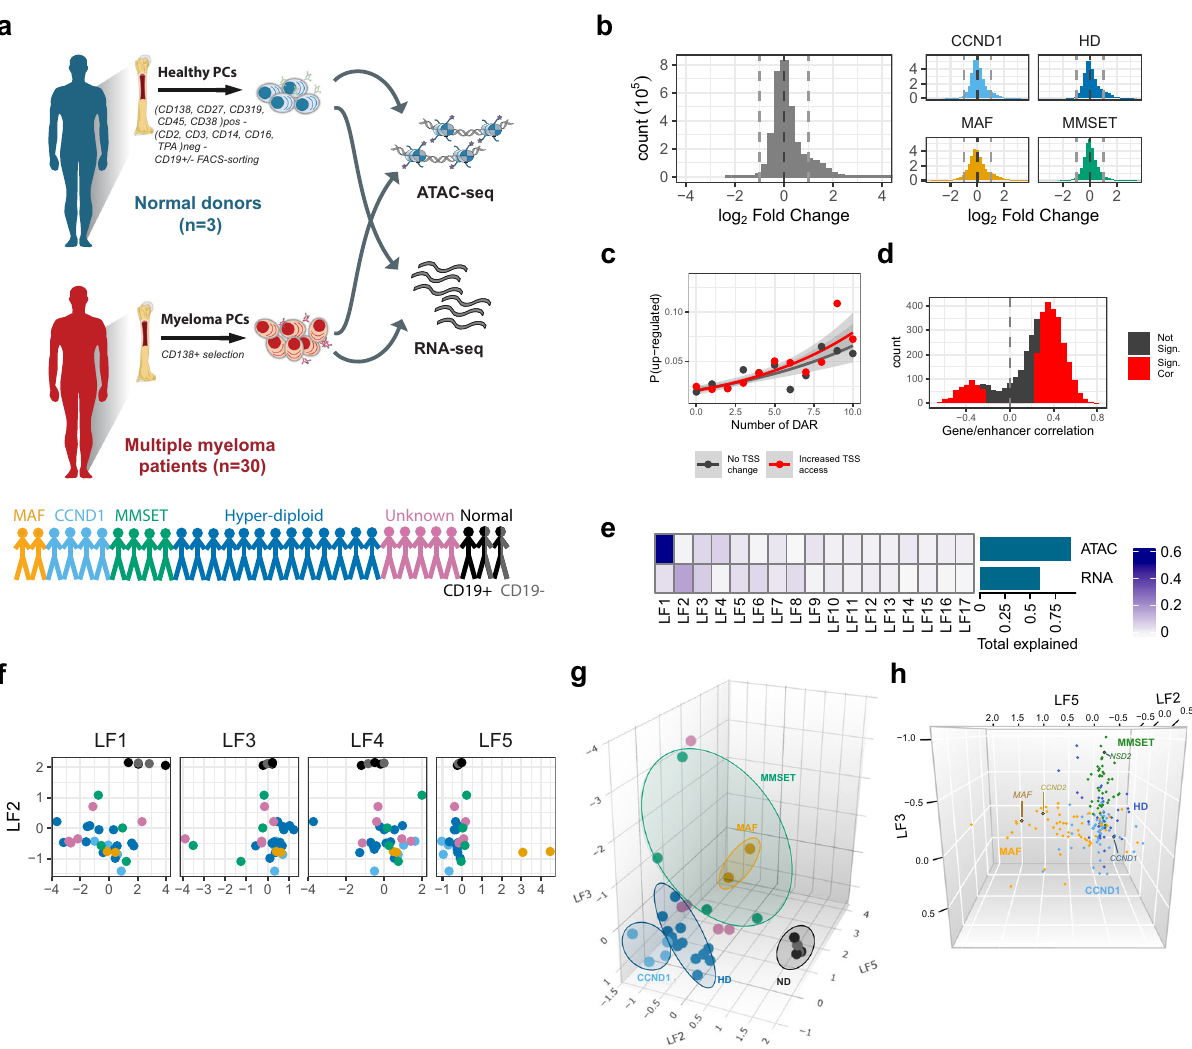
Fig. 1 Over-accessible distal chromatin classi fi es myeloma genetic subgroups. a Study patient population and design. Transcriptome and chromatin accessibility were assessed by RNA-seq and ATAC-seq respectively in myeloma PC from 30 MM patients and PC from three healthy donors. For two of the controls we obtained samples of both CD19 + and CD19 − PC. b Changes in average ATAC-seq signal over pan-myeloma (left) and subgroup (right) peaks expressed as normalized log 2 myeloma/normal PC read count. Signi fi cant changes in the pan-myleoma plot (left) are shown in a darker colour. c Logistic regression of number of differentially accessible regions (DAR) within 500 kb of a gene ( x -axis), whether a gene has a signi fi cantly more open promoter in myeloma (red – yes, black – no) on the probability of the gene being differentially upregulated in myeloma. Points represent fraction of genes upregulated with a given number of DAR within 500 kb and TSS status, and lines represent model fi t, grey ribbon 95% con fi dence interval. Genes with 10 or more DAR were pooled together. d Correlation of signal for differentially accessible ATAC-seq regions and differentially expressed genes within the same topology associating domain (TAD). e Variance explained by the fi rst 17 latent factors (LF) for each of RNA-seq and ATAC-seq signals as calculated by multi-omics factor analysis (MOFA). f , g LF scores for each sample for the fi rst fi ve latent factors in the MOFA model. Subtype for each sample is denoted by colour, as per ( a ). LF1 and LF2 distinguish normal from MM samples, LF5 distinguishes MAF and CCND1 samples from the rest. h LF scores for a subset of regions and genes used as predictors by MOFA analysis and previously identi fi ed as MM-subgroup classi fi ers 12 . The main driving oncogenes MAF, CCND1, CCND2 and NSD2 are highlighted